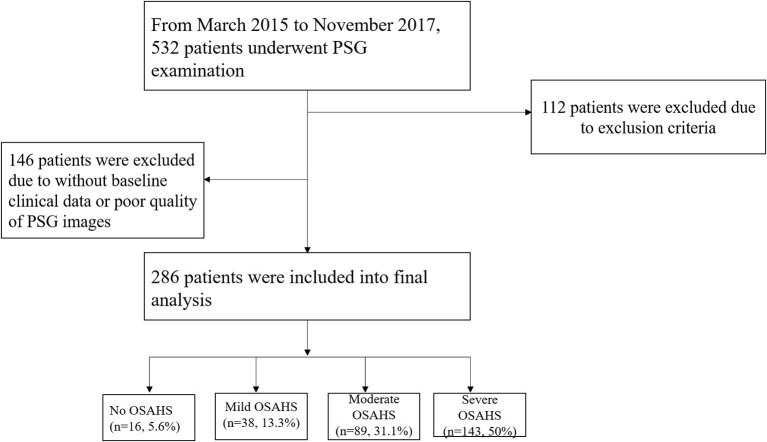
Study flowchart. OSAHS, obstructive sleep apnea-hypopnea syndrome; PSG, polysomnography.